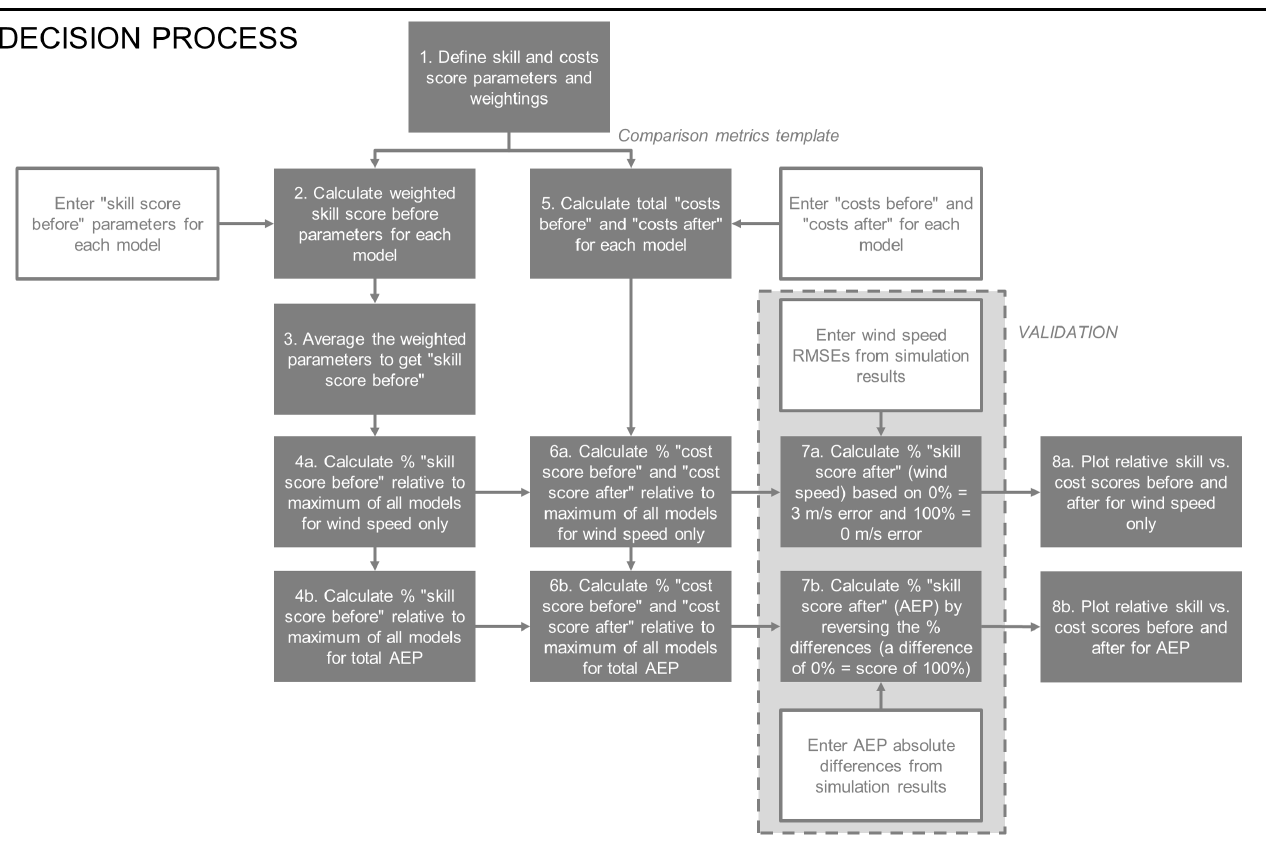
Figure 2. Overview of the decision